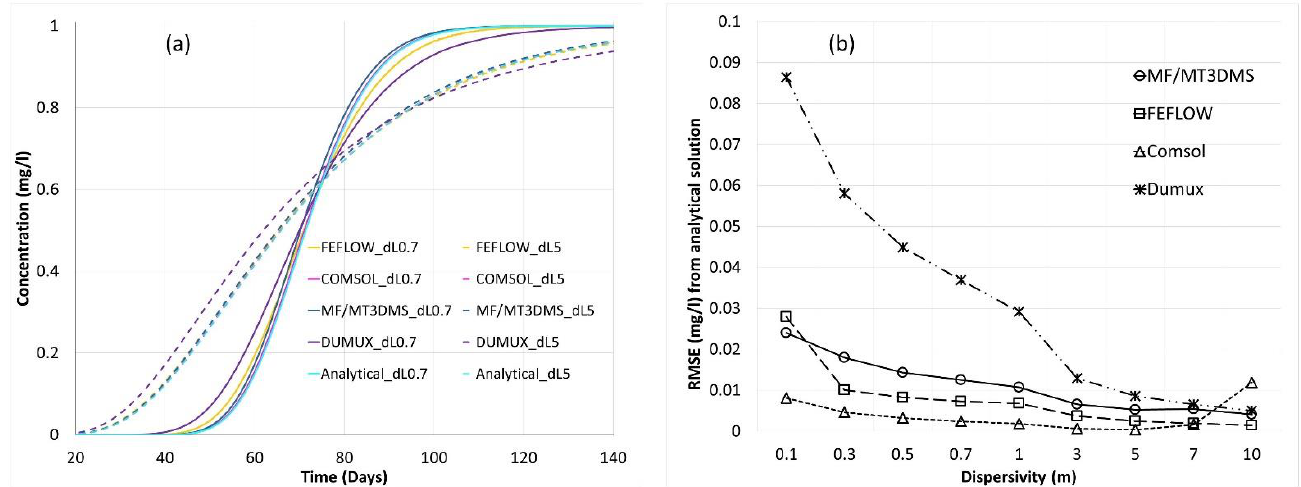
Figure 4. ( a ) Tracer breakthrough from four numerical simulators with dispersivities of 0.7 and 5 m. ( b ) The relative difference of concentration computed in numerical simulators and analytical solutions for different dispersivity values.